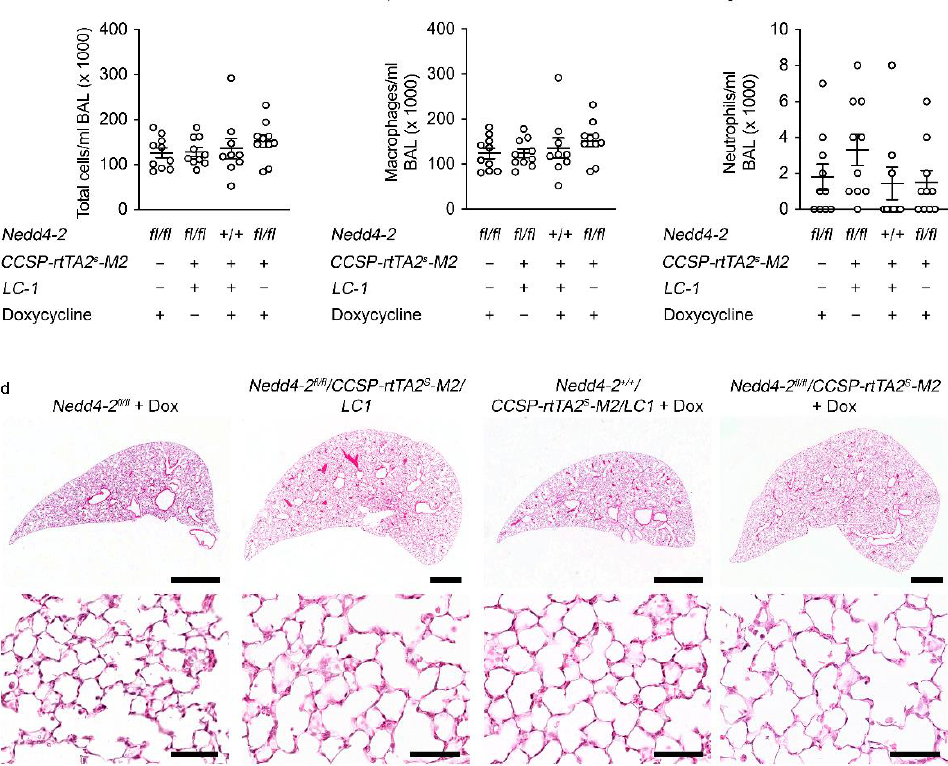
Figure A1. Pulmonary phenotypes of 3-week-old mice used as controls: ( a – d ) Total cell counts ( a ), number of macrophages ( b ) and neutrophils ( c ) in BAL and representative morphology of H&E stained lung sections ( d ) in mice with the different genotypes that served as controls to exclude potential off-target effects of the expression system. Dams were treated with doxycycline from the start of mating and offspring was studied 3 weeks after birth. Upper row, scale bars, 1 mm. Lower row, scale bars, 50 µm. n = 9–10 mice per group. Data are shown as mean ± S.E.M.